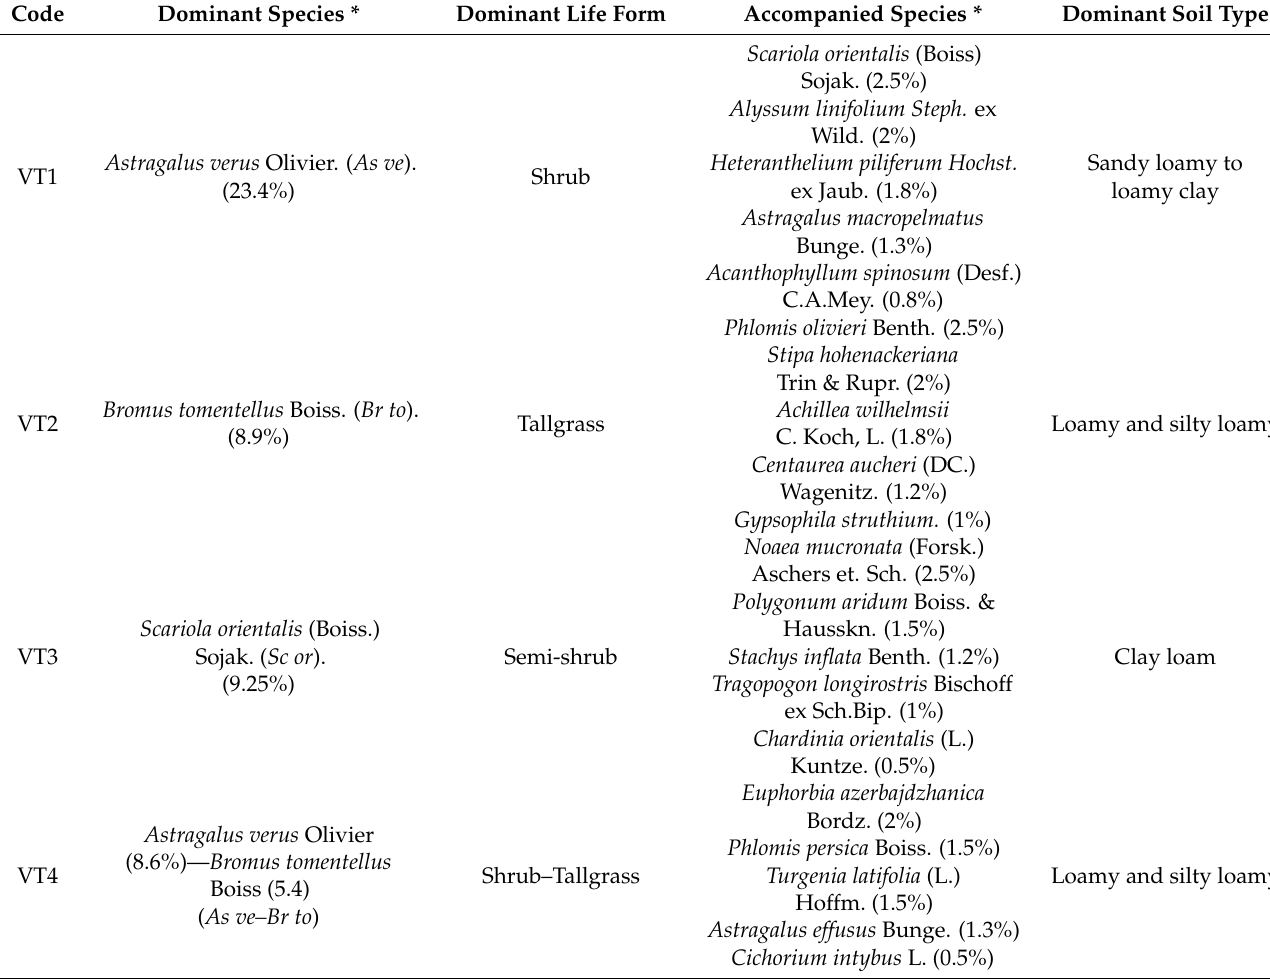
Table 1. The identified VTs and their vegetational characteristics in the study area. Code Dominant Species * Dominant Life Form Accompanied Species * Dominant Soil